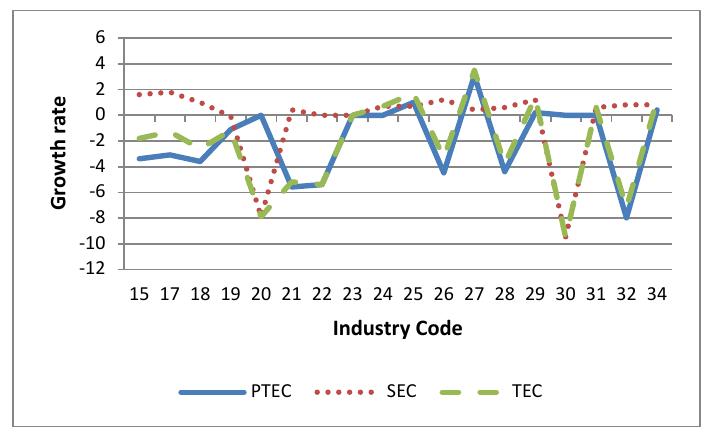
FIGURE 1: The post-reform period: TEC and its components Source: Authors’ analyses Radio, television and communication equipment (ISIC 32) recorded the lowest efficiency during the post-reform period. In the competitive environment of the post-reform period, the sub- sector group of basic metals (ISIC 27) was found to be the most efficient one. Efficiency behaviour during post-reform period